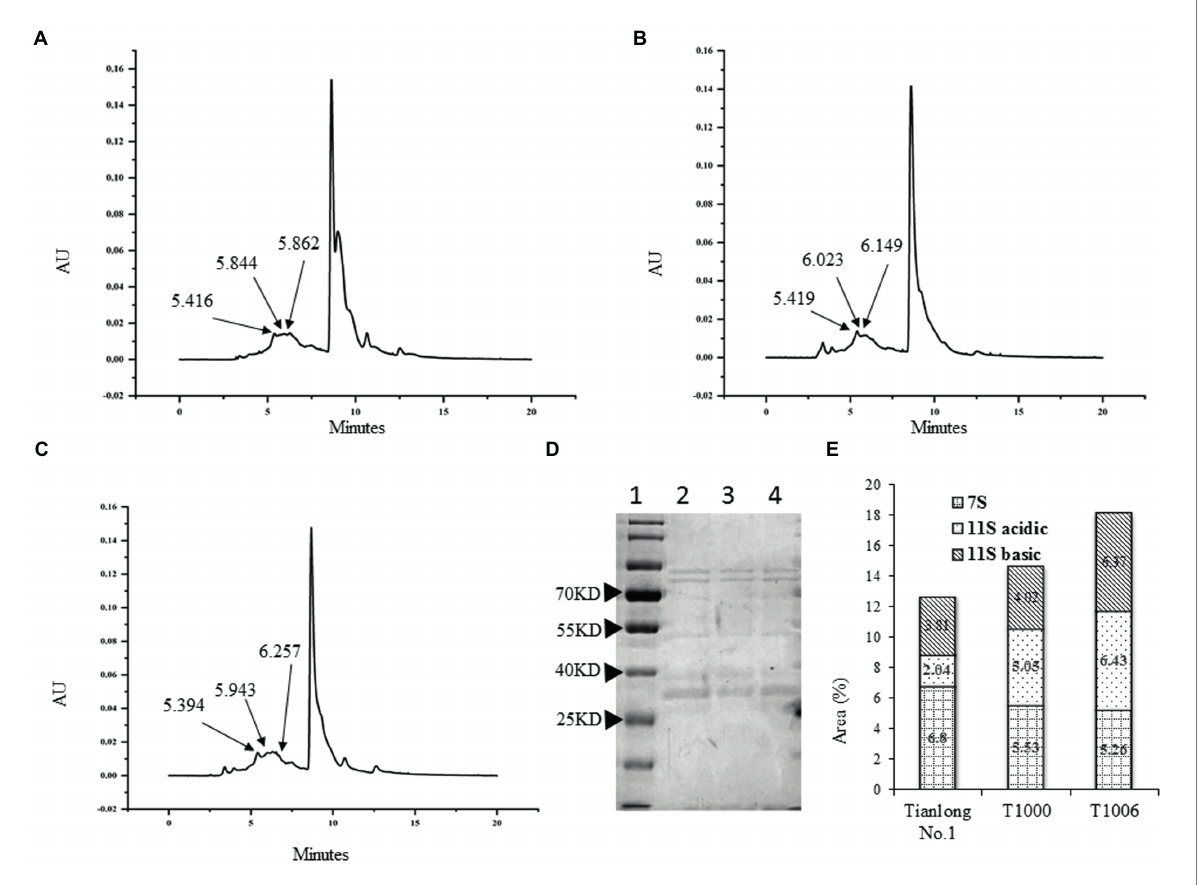
FIGURE 4 Gel permeation chromatography of SPI obtained from different plants. (A–C) are molecular weight (Mw) distribution profiles for the ‘Tianlong No. 1’, T1000, T1006 lines, respectively. (D) The proteins collected from elution times of 5.0–6.5 min were separated by SDS–PAGE. Lane 1, Lane 2, Lane 3, and Lane 4 represent the protein marker, T1000 lines, ‘Tianlong No. 1’, and T1006 transgenic plants, respectively. (E) The area distribution of 7S, 11S acidic, and 11S basic fractions from ‘Tianlong No. 1’, T1006 and T1000 plants,